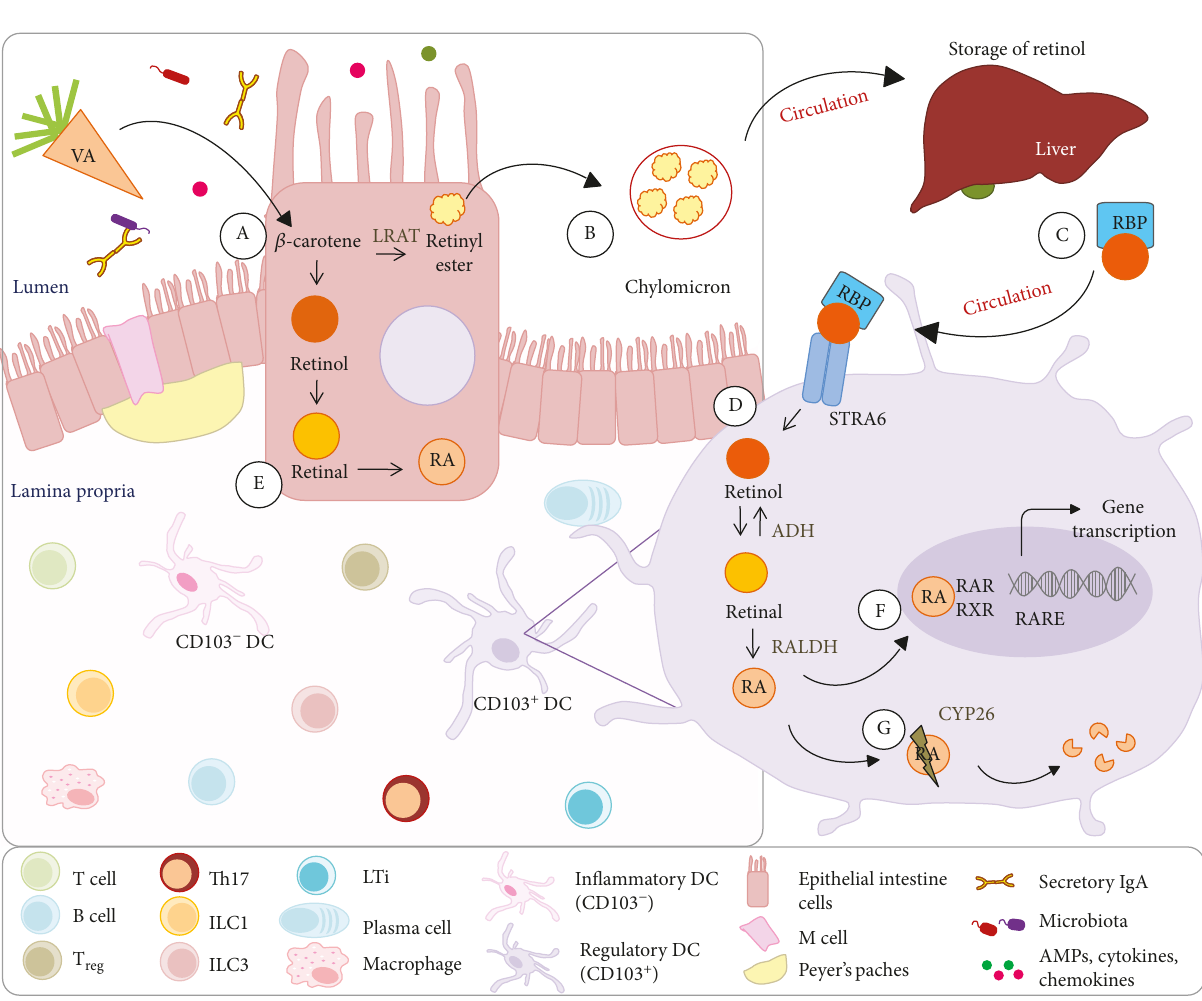
Figure 1: RA metabolism and signaling. (A) Vitamin A and its precursors ( β -carotene) obtained from diet are absorbed by intestinal epithelium cells and esteri fi ed in retinyl esters by the enzyme lecithin retinol acyltransferase (LRAT). (B) Retinyl esters are packed with chylomicrons and enter general circulation where they are captured by hepatocytes and stored as retinol. (C) The retinol binds to retinol binding protein (RBP) in the liver and is carried through the bloodstream. This complex is recognized via the stimulated by retinoic acid 6 (STRA6) receptor, which mediates the absorption of extracellular retinol to cytosol. (D) After uptake, RA is generated from retinol by two sequential reactions. First, retinol is oxidized into retinal by enzyme alcohol dehydrogenase (ADH). Subsequently, in CD103 + DCs, retinal is oxidized by the enzyme retinal dehydrogenase (RALDH) to generate RA. (E) Intestinal epithelium cells can also metabolize vitamin A after absorption into retinal and RA, which can be directly released into the intestinal mucosa. (F) RA interacts with nuclear receptors, such as the retinoic acid receptor (RAR) and retinoid receptor X (RXR), to regulate the transcription of several target genes by binding the retinoic acid-responsive elements (RAREs) in DNA. (G) Control of the RA concentration in tissues is performed by a group of enzymes that belong to the cytochrome P450 family 26 (CYP26), which catalyzes RA present in the cytosol to generate the oxidized